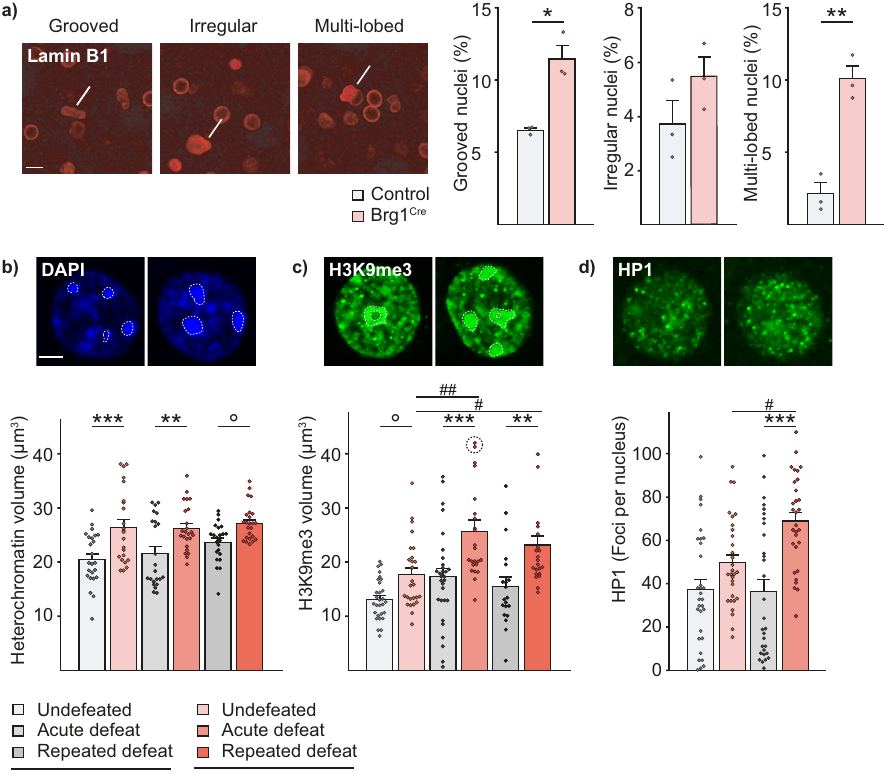
Fig. 6 Changes of nuclear and chromatin conformation in absence of BRG1. a Nuclear abnormalities (pointed by yellow bars) in the NAc of control and Brg1 D1Cre mice using Lamin B staining with percentage of grooved, irregular and multilobed nuclei ( n = 3/3 mice). Scale bar = 20 μ m. Two-sided T-test. Grooved nuclei ** p = 0.0066, multilobed nuclei ** p = 0.0022. b Representative DAPI staining in nuclei from control and Brg1 D1Cre acutely defeated mice with heterochromatin domains circled in dashed white lines. Total volume of heterochromatin in control and Brg1 D1Cre mice undefeated, 1 h after a single defeat or 24 h after repeated social defeat. Scale bar = 5 μ m. n = 24 nuclei in 4 animals in each condition except for controls with repeated defeat for which n = 23 in 4 animals. Main genotype effect F(1,135) = 30.76; p < 0.001. Two-way ANOVA followed by Bonferroni correction control vs Brg1 D1Cre ° p = 0.0603, ** p = 0.0052, *** p = 0.0003. c Representative H3K9me3 staining in nuclei from control and Brg1 D1Cre acutely defeated mice with quanti fi ed domains circled in dashed white lines. Total volume of H3K9me3 staining in control and Brg1 D1Cre mice undefeated (respectively n = 29 and n = 27 in 5 mice), 1 h after a single defeat (respectively n = 30 in 5 mice and n = 23 in 4 mice) or 24 h after repeated social defeat (respectively n = 20 and n = 22 in 4 mice). For acutely defeated mutant mice, two points out of scale (52.0 and 52.9 μ m 3 ) are pictured circled. Scale bar = 5 μ m. Main genotype effect F(1,145) = 29.31; p < 0.0001, main stress effect F(2,145) = 8.66; p = 0.0003. Two-way ANOVA followed by Bonferroni correction control vs Brg1 D1Cre ° p = 0.0856, ** p = 0.0047, *** p = 0.0004; unstressed vs acute stress ## p = 0.0011; unstressed vs repeated defeat # p < 0.0403. d Representative HP1 staining in nuclei from control and Brg1 D1Cre acutely defeated mice. Number of HP1 foci in control and Brg1 D1Cre mice undefeated or 1 h after a single defeat. n = 30 nuclei in 5 animals in each condition. Main stress effect F(1,116) = 3.99; p < 0.05. Main genotype effect F(1,116) = 23.47; p < 0.0001. Interaction stress x genotype F(1,116) = 4.78; p = 0.0309. Two-way ANOVA followed by Bonferroni correction control vs Brg1 D1Cre *** p < 0.0001; unstressed vs acute stress ## p = 0.0075. Data are represented as mean ± s.e.m. Data are provided in a Source Data fi